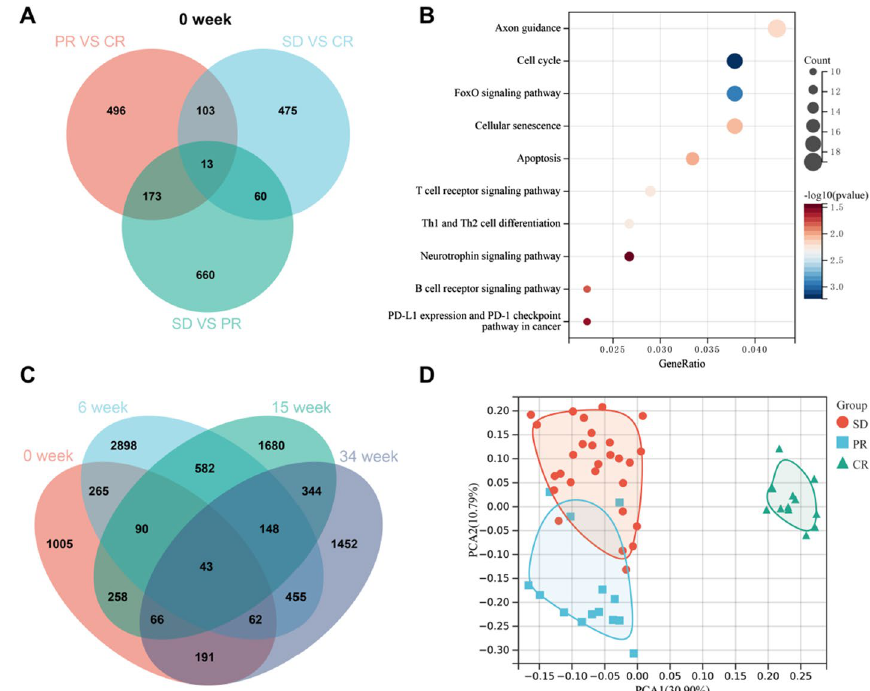
Fig. 2 Identification of response-related genes. a 1981 DEGs at week 0 were identified by comparing the differences between SD, PR, and CR patients. b KEGG pathway analysis of 1981 DEGs at week 0. The size of the circle represents the number of genes enriched. c Venn diagram showing the number of crossover genes with altered expression from week 0 to 34. A total of 43 treatment response-related DEGs that were differentially expressed at all time points. d Principal component analysis based on the transcriptome profiles of 43 RRGs, showing a remarkable difference on transcriptome among SD, PR and CR